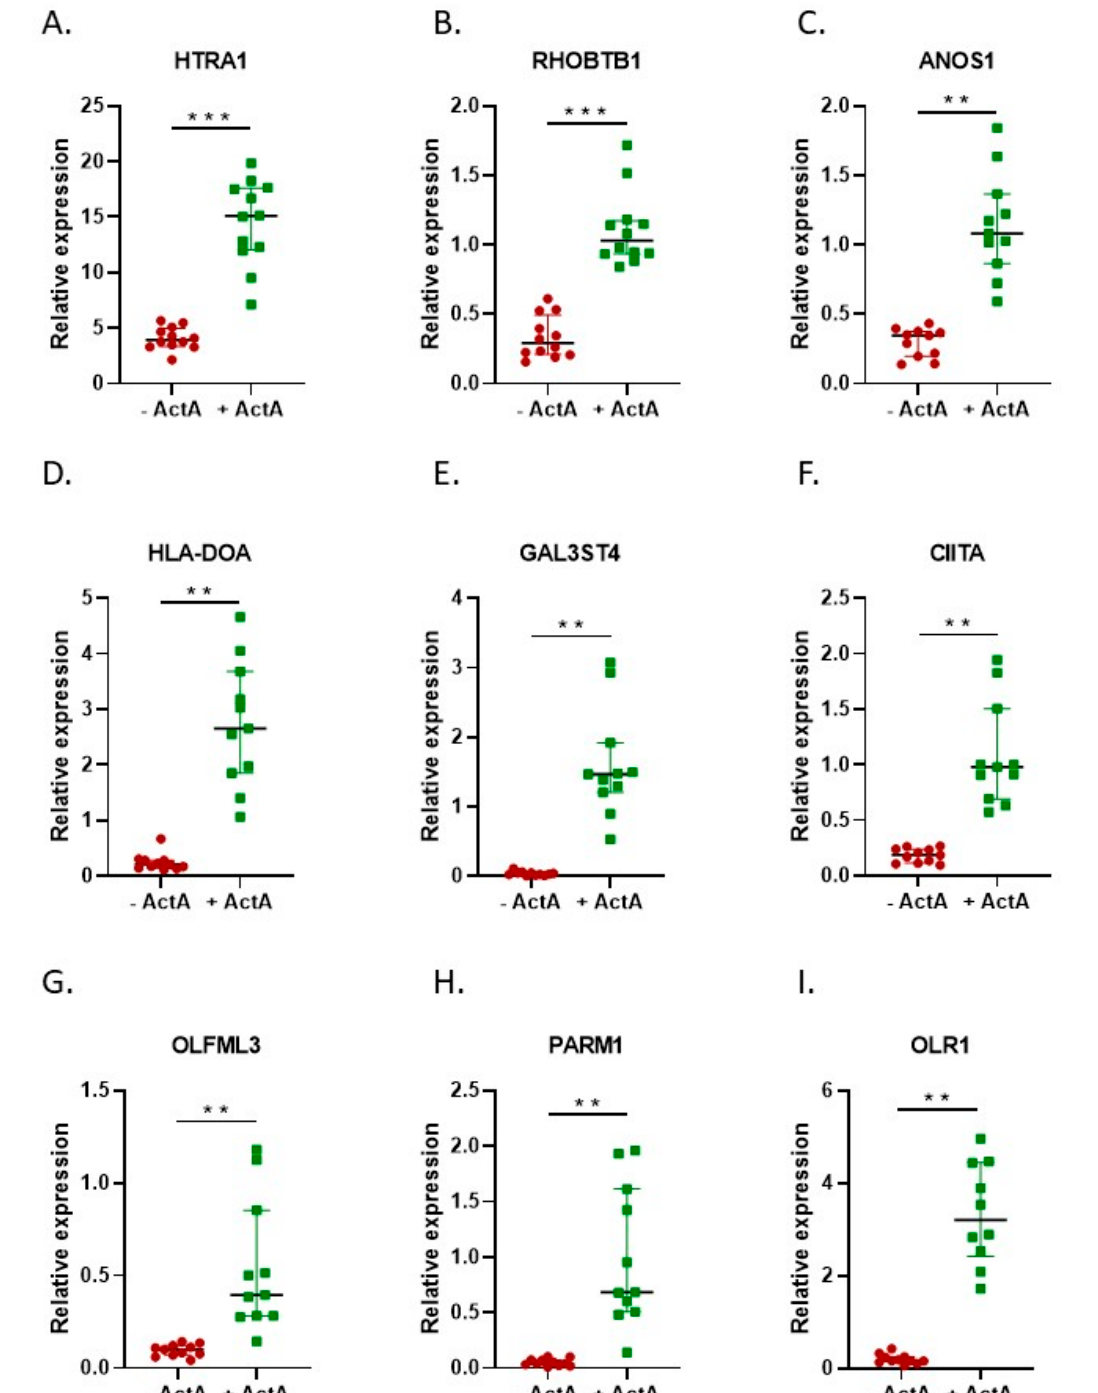
Figure 7. The qPCR confirmed the RNA-seq data. qPCR data for the most significantly differentially expressed genes depicted in the volcano plot. Data are presented as medians with the interquartile range. The qPCR data confirmed the RNA sequencing data. ( A – I ) qPCR of genes upregulated by Activin-A. − Activin-A, n = 11; +Activin-A, n = 11. Wilcoxon matched pairs signed rank test ** p < 0.01, *** p < 0.001.